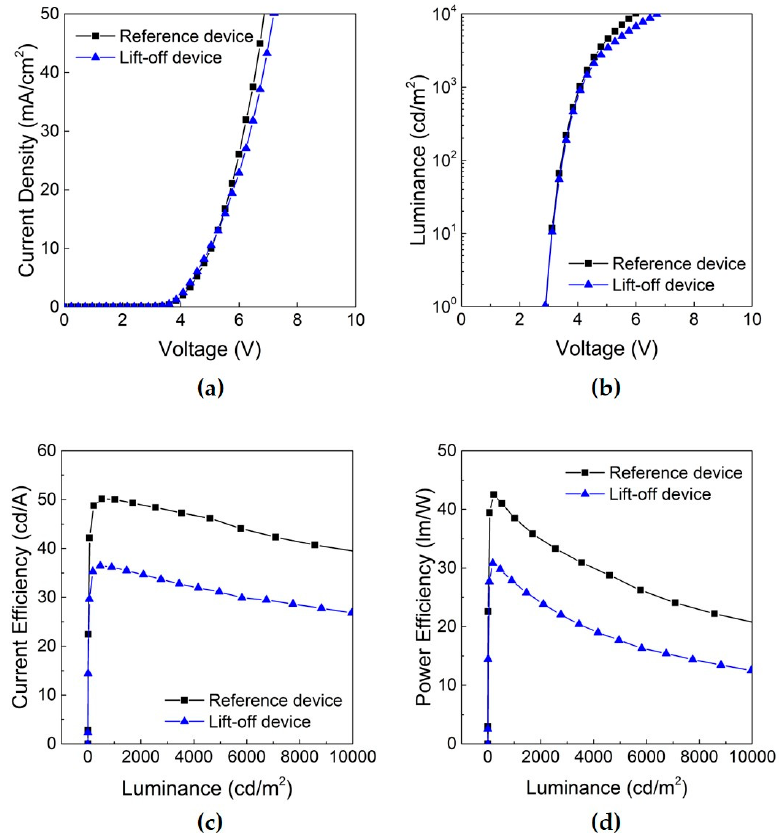
Figure 6. Current-voltage-luminance (JVL) characteristics of the OLED subjected to the lift-off process (blue line) and the non-processed reference (black line): ( a ) current density-voltage; ( b ) luminance-voltage; ( c ) current efficiency-luminance; ( d ) power efficiency-luminance.